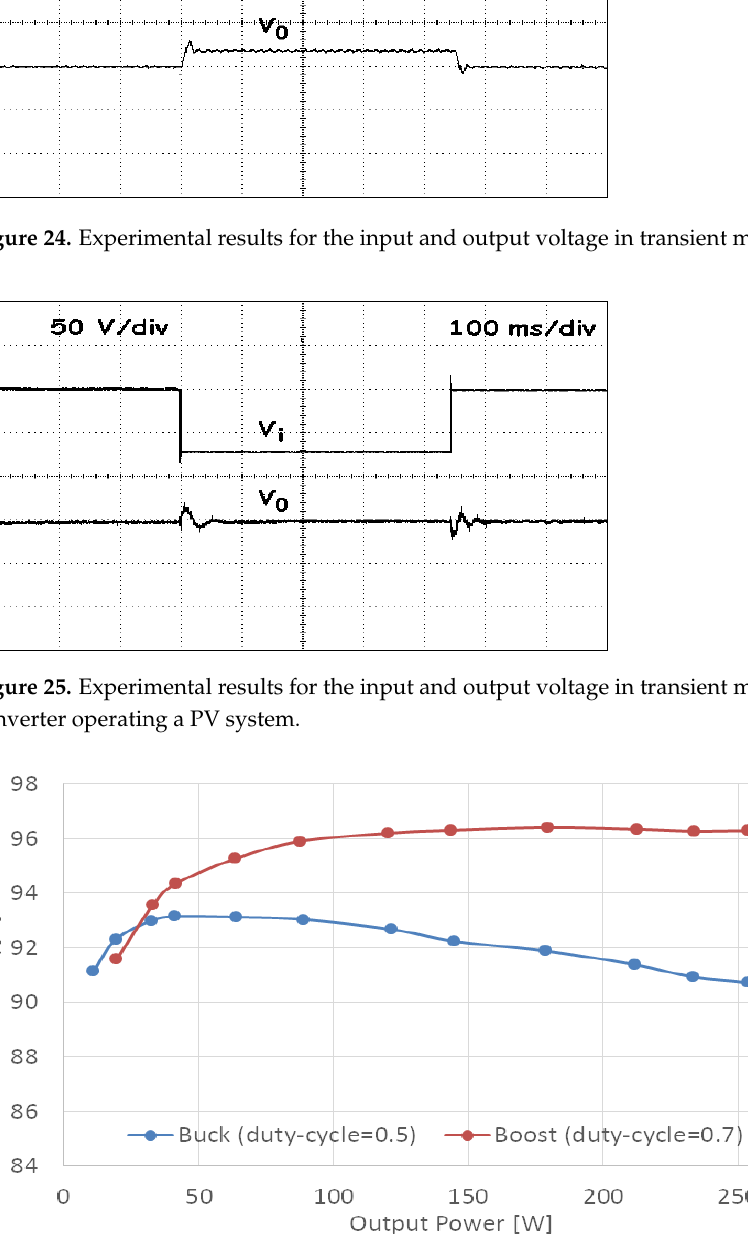
Figure 26. Experimental results regarding the efficiency of the proposed converter operating in buck and boost modes as a function of the output power.